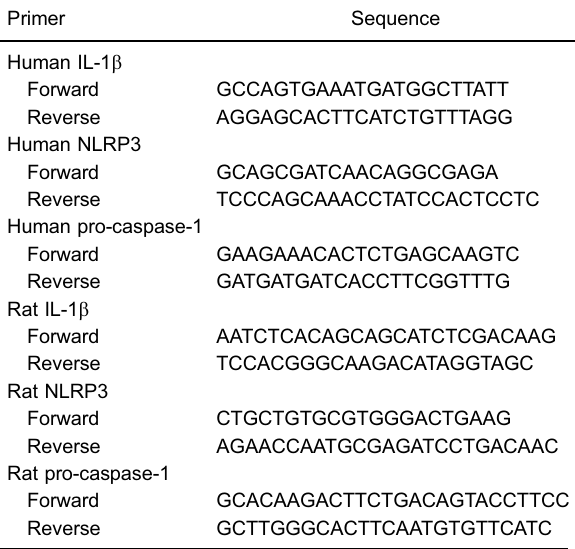
Table 1 . Primer sequences used in the